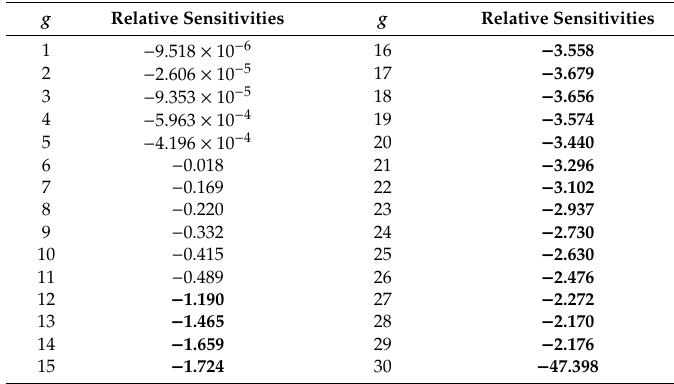
(cid:16) (cid:17) N 6,2 , σ g , g = 1, ... ,30. t ,6